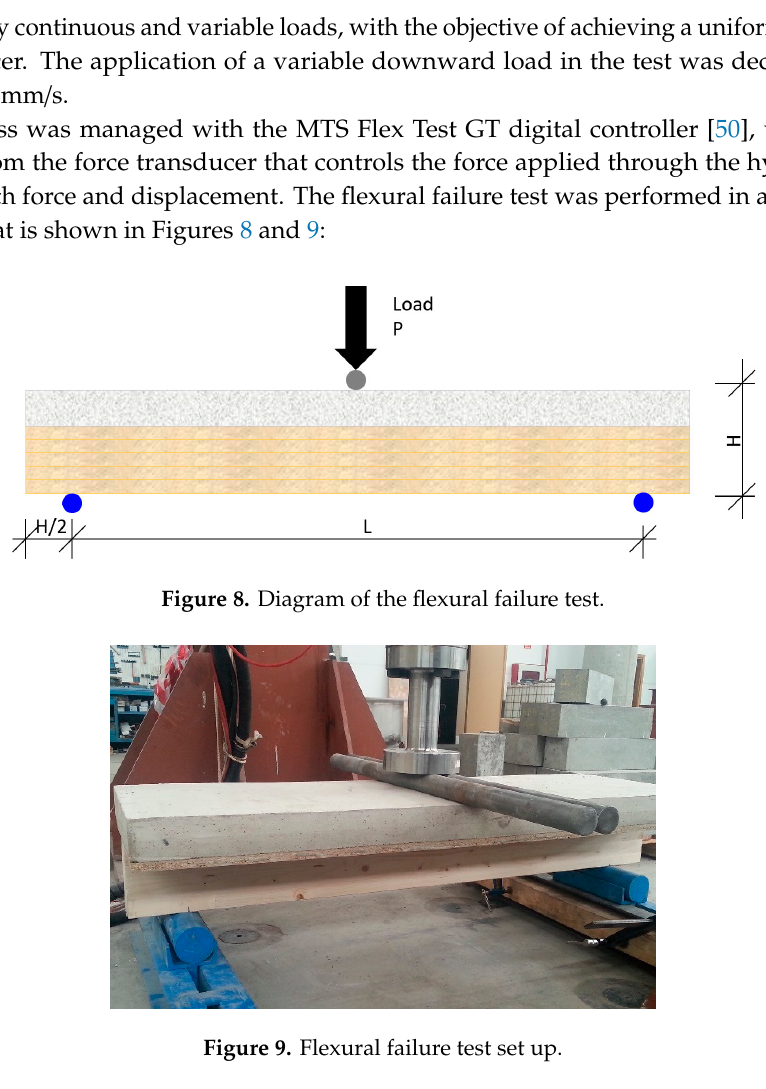
Figure 9. Flexural failure test set up.